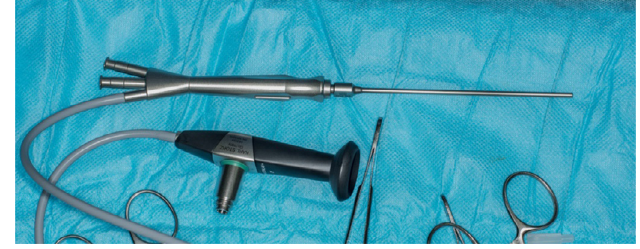
Fig. 11. Sialendoscope.